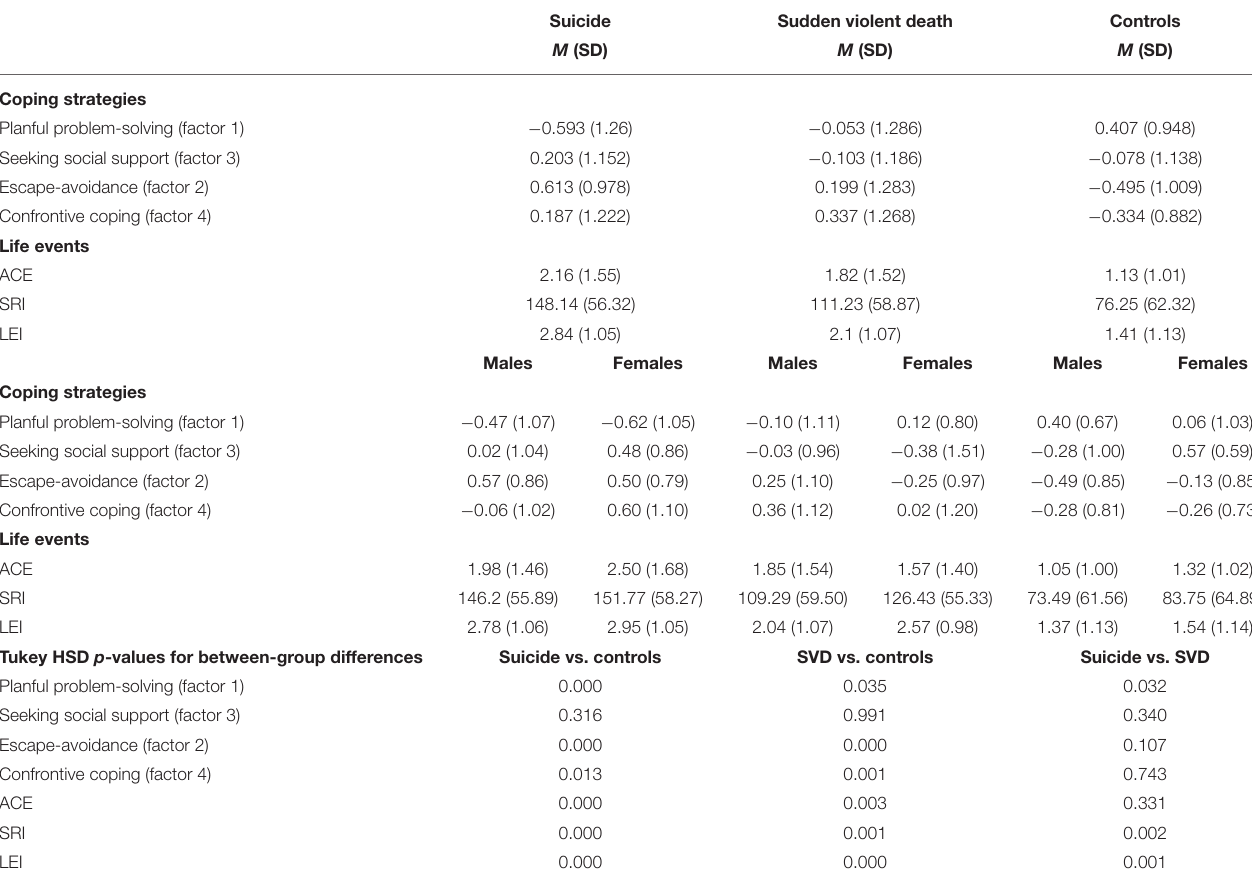
TABLE 3 | Mean scores (and SD) on the four coping factors as well as three measures of life events, separately for the three groups.